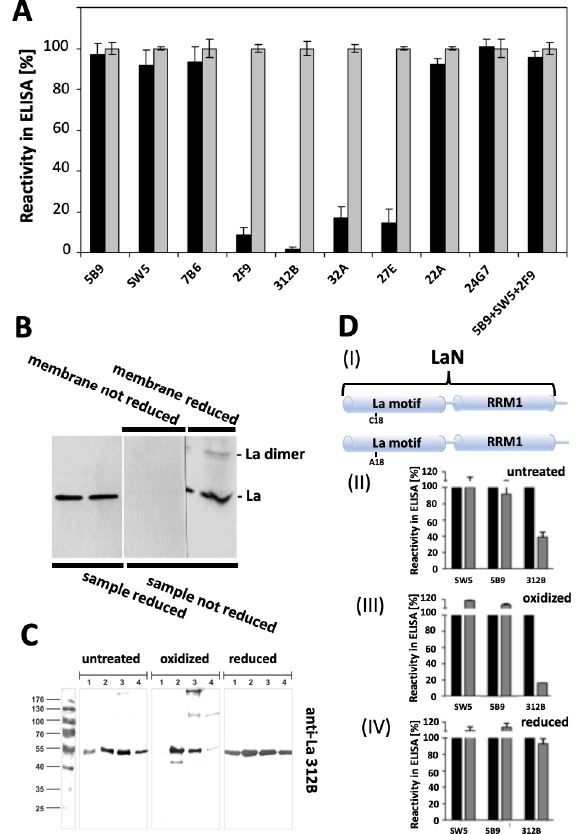
Figure 9 . Identification of anti-La mAbs to the reduced form of La protein. ( A ) The reactivities of the anti-La mAbs 2F9, 312B, 32A, and 27E, which are directed against the La motif and the anti-La mAbs 22A, 24G7, which are directed against the RRM1 domain [45] were tested by ELISA against wild-type La (black bars) and the triple cysteine mutant (gray bars). In parallel, the reactivities were determined for the anti-La mAbs 5B9, 7B6, SW5. ( B ) SDS–PAGE/immunoblotting using the anti-La mAb 2F9. A recombinantly expressed wild-type La protein sample was treated prior to electrophoresis under reducing conditions (sample reduced). The same protein sample was not reduced prior to electrophoresis (sample not reduced, membrane not reduced). The latter blot was cut into two halves. One-half was rinsed in PBS under reducing conditions and tested again against the anti-La mAb 2F9 (sample not reduced, membrane reduced). The position of wild-type La and dimers of La are indicated. ( C ) SDS–PAGE/immunoblotting using the anti-La mAb 312B. Wild-type La protein (lanes 1), the triple cysteine mutant (lanes 2), the mono cysteine mutant (lanes 3) and the double cysteine mutant (lanes 4) were analyzed. La protein samples were used as obtained after nickel affinity chromatography (untreated). Alternatively, the protein samples were treated with CuSO 4 prior to electrophoresis (oxidized). In both cases, the protein samples were not reduced prior to electrophoresis. As a third alternative, the protein samples were reduced prior to electrophoresis (reduced). ( D ) Redox sensitivity of the La motif. An ELISA was performed similarly to ( A ) using instead of wild-type La protein the C-terminally truncated La fragment LaN (gray bars). The LaN sequence contains only the cysteine residue Cys18. In parallel, we tested a mutant LaN fragment in which the cysteine residue Cys18 was mutated to alanine (black bars). The used La fragments are schematically shown in (I). The LaN fragments protein samples were used as obtained after nickel affinity chromatography (II, untreated) or treated with CuSO 4 during coating of the ELISA plates (III) or reduced during coating (IV,